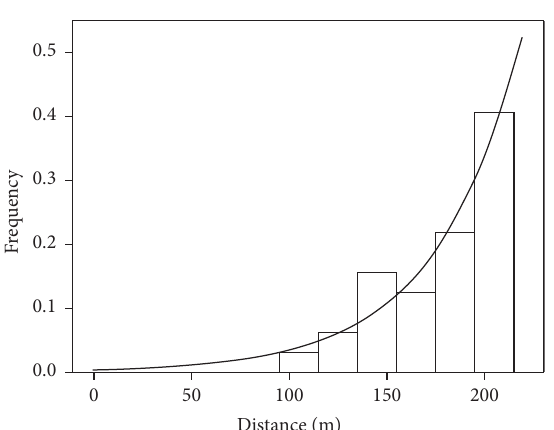
Figure 6: Lane-changing willingness